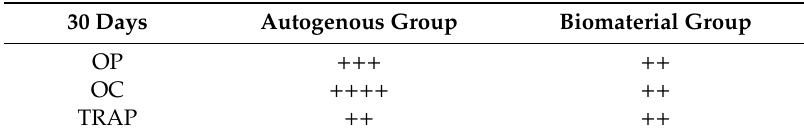
Table 3. Osteopontin (OP), Osteocalcin (OC), and Tartrate-resistant Acid Phosphatase (TRAP) immunostaining at 60 days for the experimental